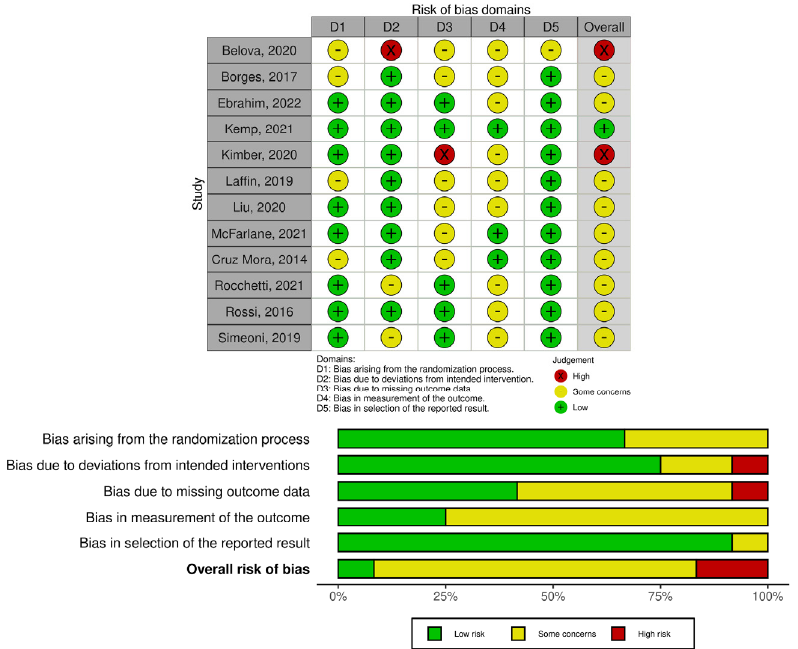
Figure 2. Risk of bias of randomized trials (RoB 2). Belova et. al., 2020 [78]; Borges et al., 2017